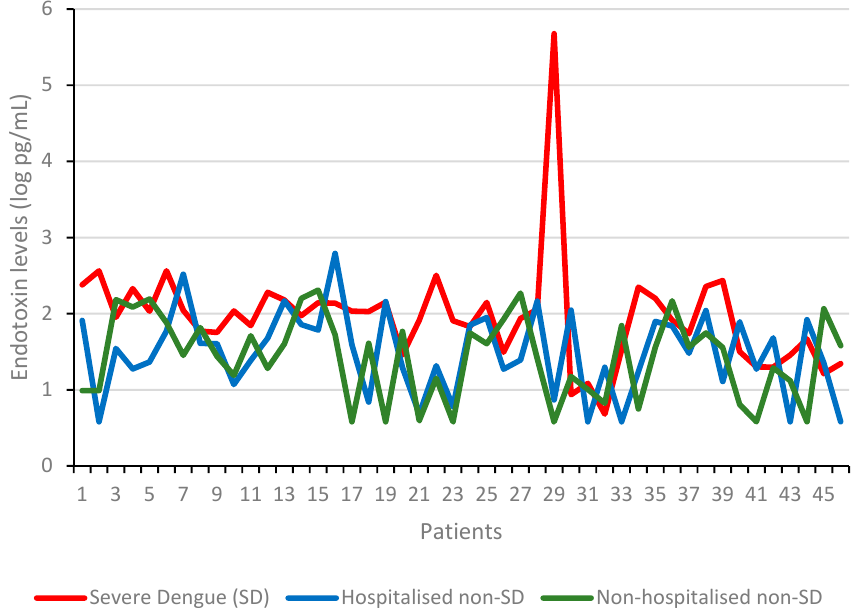
Figure 3. Serum endotoxin levels of SD, hospitalised non-SD and non-hospitalised non-SD patients in Barbados.